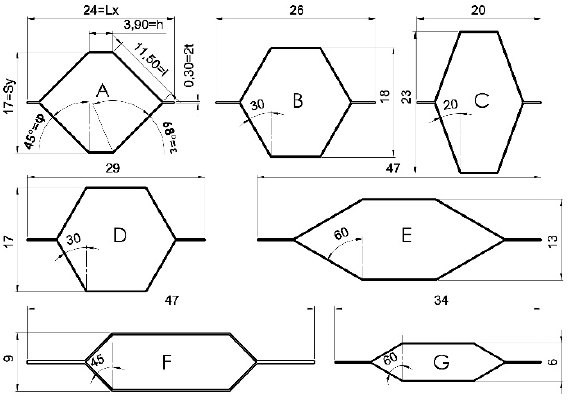
Figure 1. The shape of hexagonal cells.